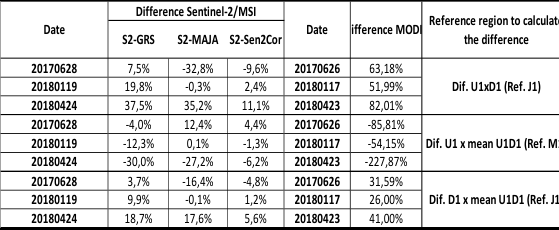
Table 5 – Difference between estimated suspended sediment concentrations by sampled region and